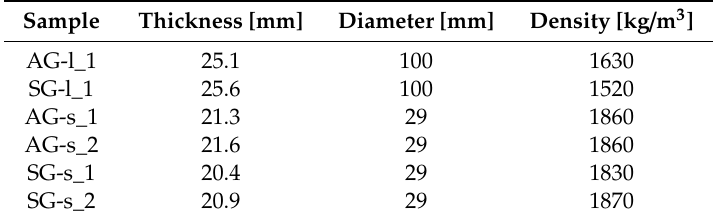
Table 2. Characteristics of the examined samples for acoustic measurements.